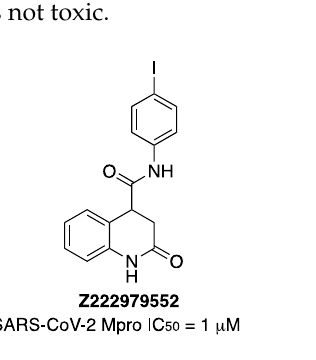
Figure 12. Chemical structure of compound Z222979552